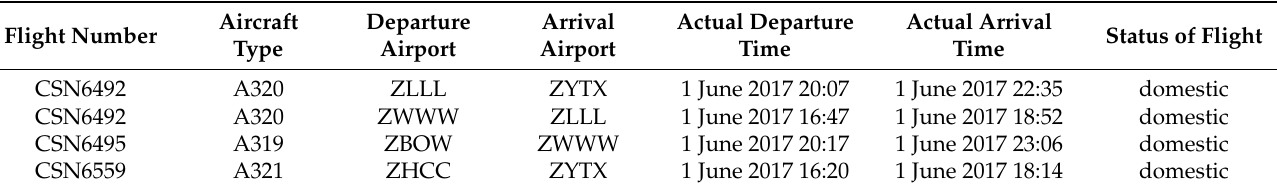
Table 1. An example of the flight information.